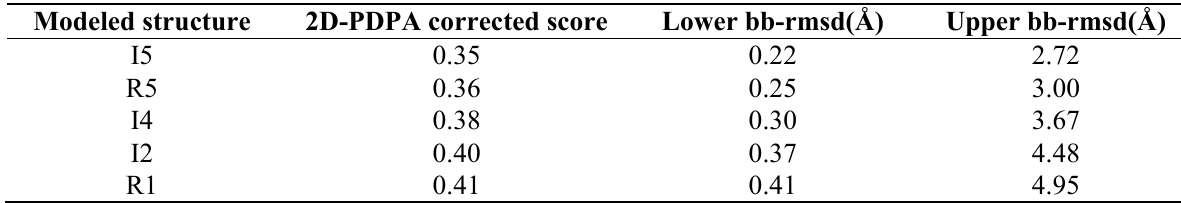
Table 8. Results of 2D-PDPA analysis of modeled structures for Pf2048 with the estimated range of bb-rmsd to the solution state structure using 1A1Z as a template for the interpretation